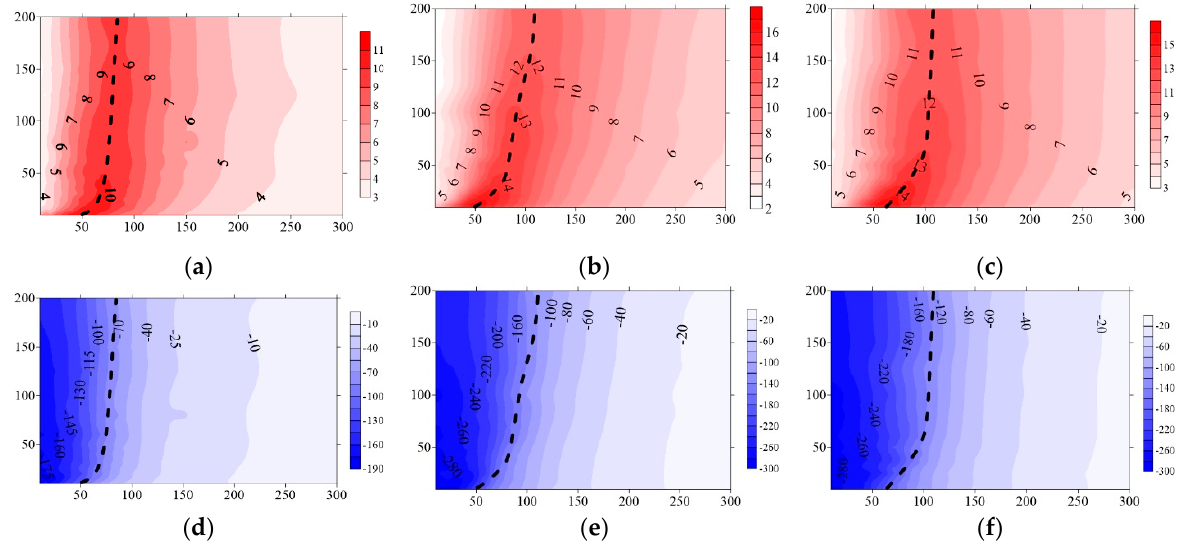
Figure 5. Contours of the tangential velocity and pressure drop distributions ( S stands for the swirl ratio). ( a ) Tangential velocity, S = 0.15; ( b ) tangential velocity, S = 0.35; ( c ) tangential velocity, S = 0.72; ( d ) pressure drop, S = 0.15; ( e ) pressure drop, S = 0.35; ( f ) pressure drop, S = 0.72. The maximum pressure drop was observed at the center of the tornado vortex